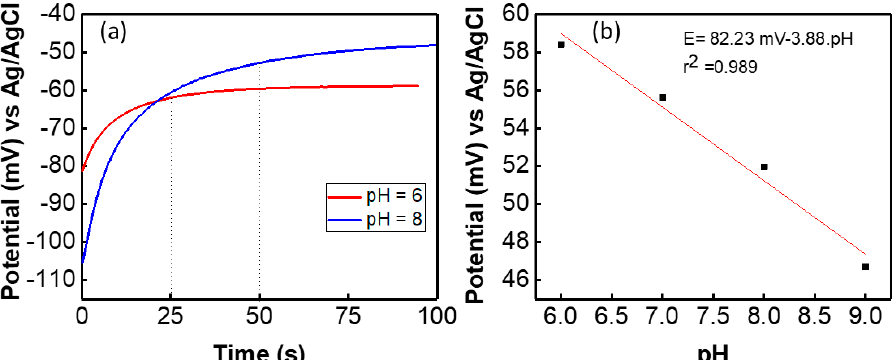
Figure 4. ( a ) Potential response of the sensor in pH buffer solution and ( b ) open circuit potential of the sensor with different pH value of solution.